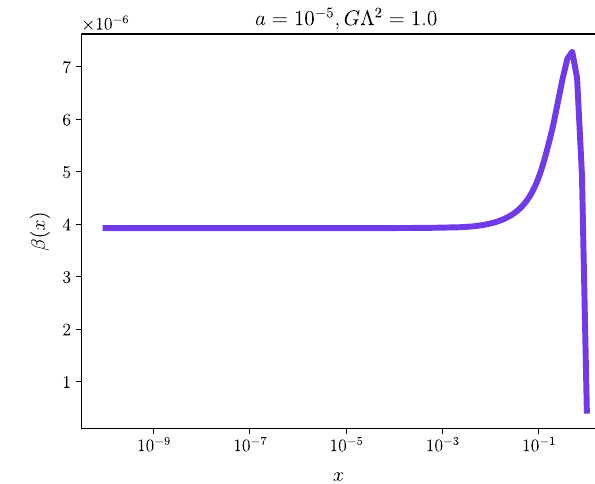
Fig. 6 β( x ) as a function of x from solving Eq. (28) with a = 10 − 5 and G Λ 2 =